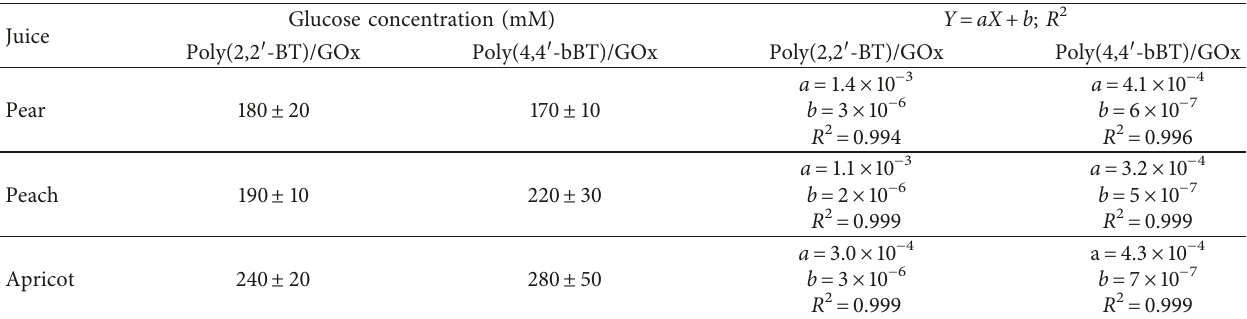
Table 3: Mean values of glucose concentration and standard deviation in three different fruit juices (pear, peach, and apricot) with two different GOx biosensors ( n � 3 replicates for each